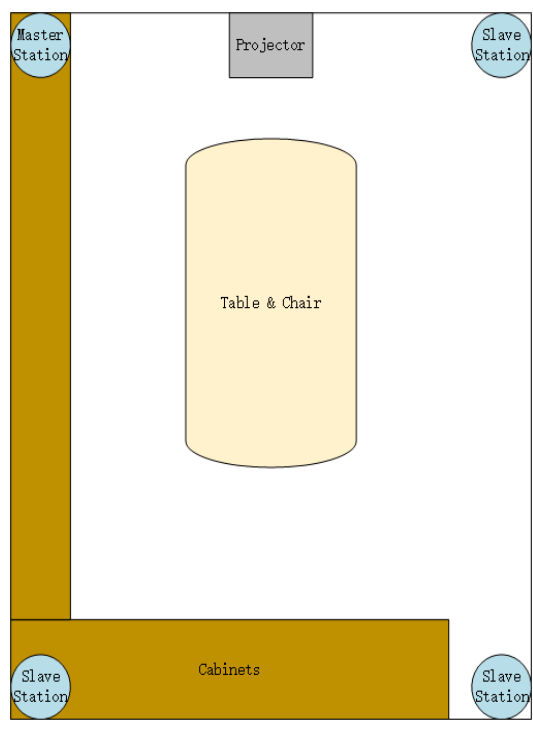
Figure 4. Plan of experimental area.